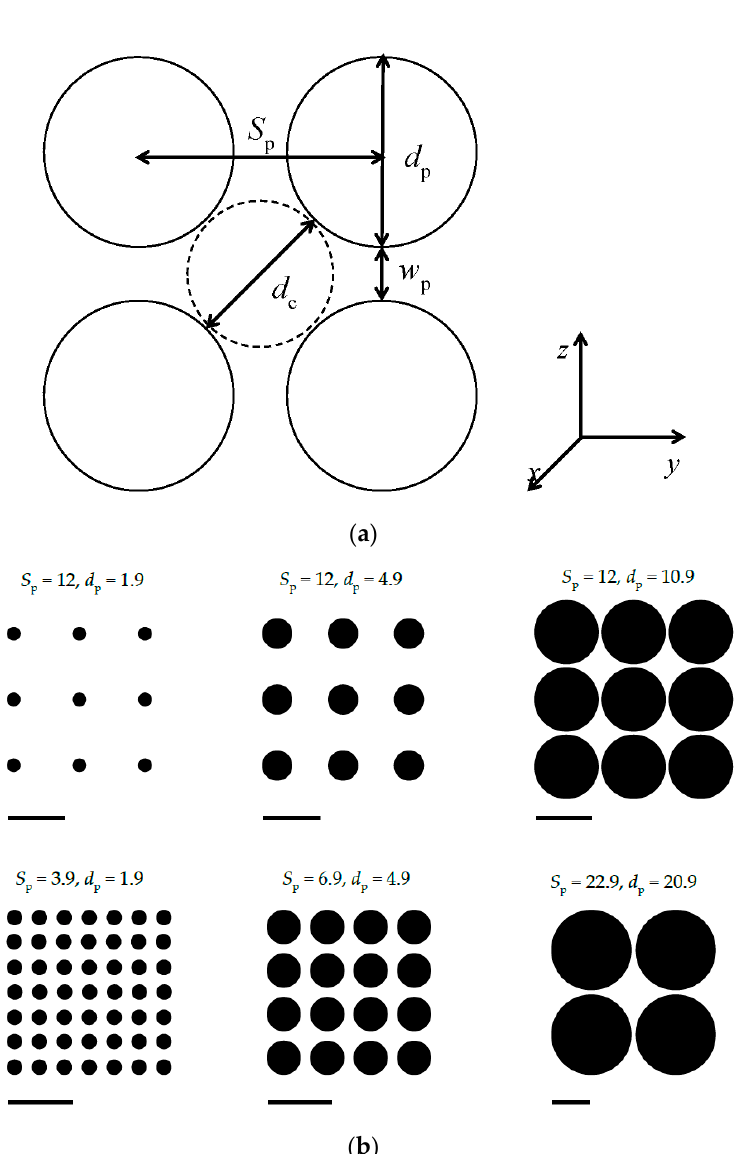
Figure 1. Cross-sectional view through four adjacent nanoposts defining the parameters of the nanopost square-lattice arrangement. S p is the closest separation between the centers of two adjacent nanoposts, d p is the diameter of nanoposts, w p = S p − d p is the closest distance between the walls of two adjacent nanoposts, i.e., the passage width, and d c = √ 2 S p − d p is the diameter of a quasi-channel which is a gauge of the size of the interstitial space embraced by four neighboring nanoposts ( a ). Selected geometries of the post arrays with the constant post separation (upper row) and with the constant passage width (lower row). The lengths of the bars are 10 σ ( b ).